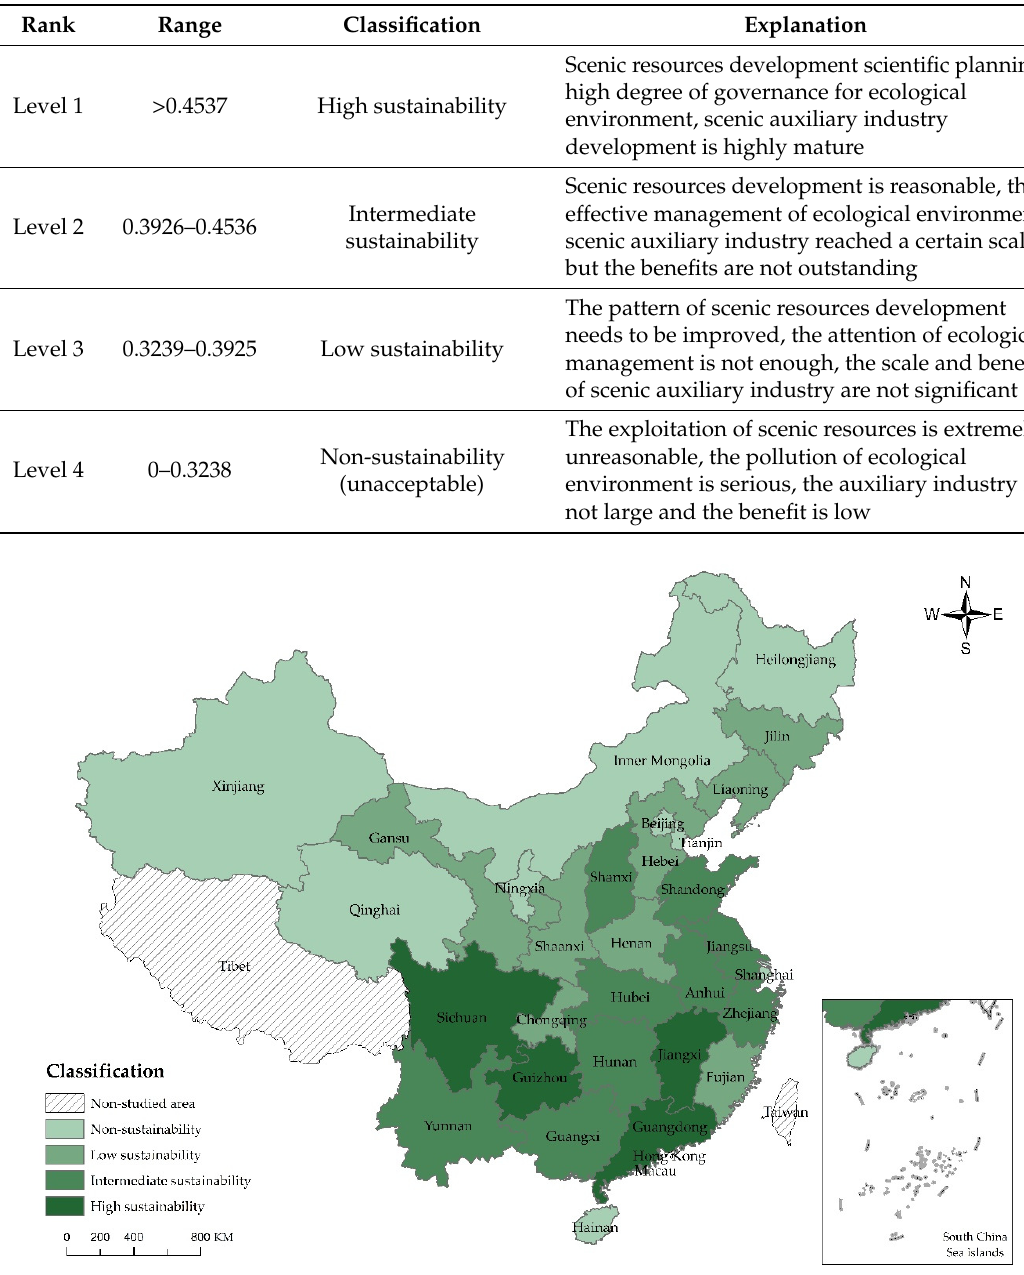
Figure 3. Comparison chart of self ‐ sustainable capacity of scenic spots in China.